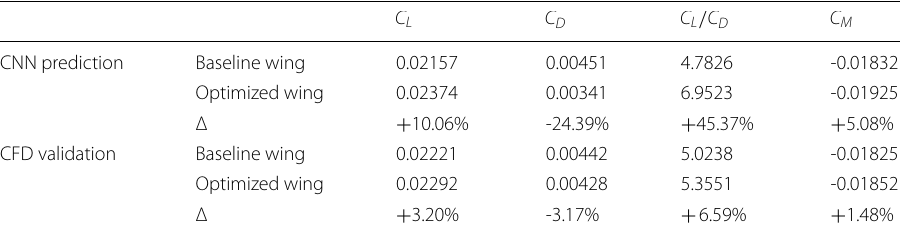
Table 11 Comparison of aerodynamic performance obtained from the CNN prediction and the CFD validation for the baseline and optimized wings (optimization case 2) C L C D C L / C D C M CNN prediction Baseline wing 0.02157